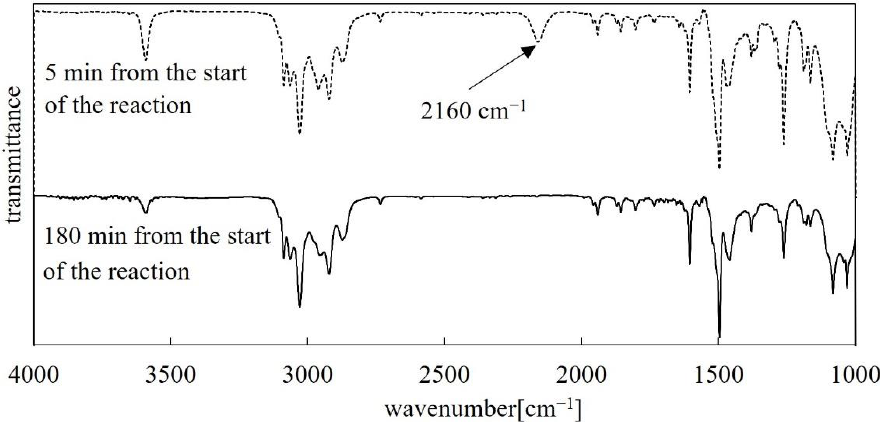
Figure 4. FT-IR spectra of the reaction mixture (FS2, toluene, catalyst, PMHS) recorded: 5 min from the start of the reaction—dotted line; 180 min from the start of the reaction—solid line.